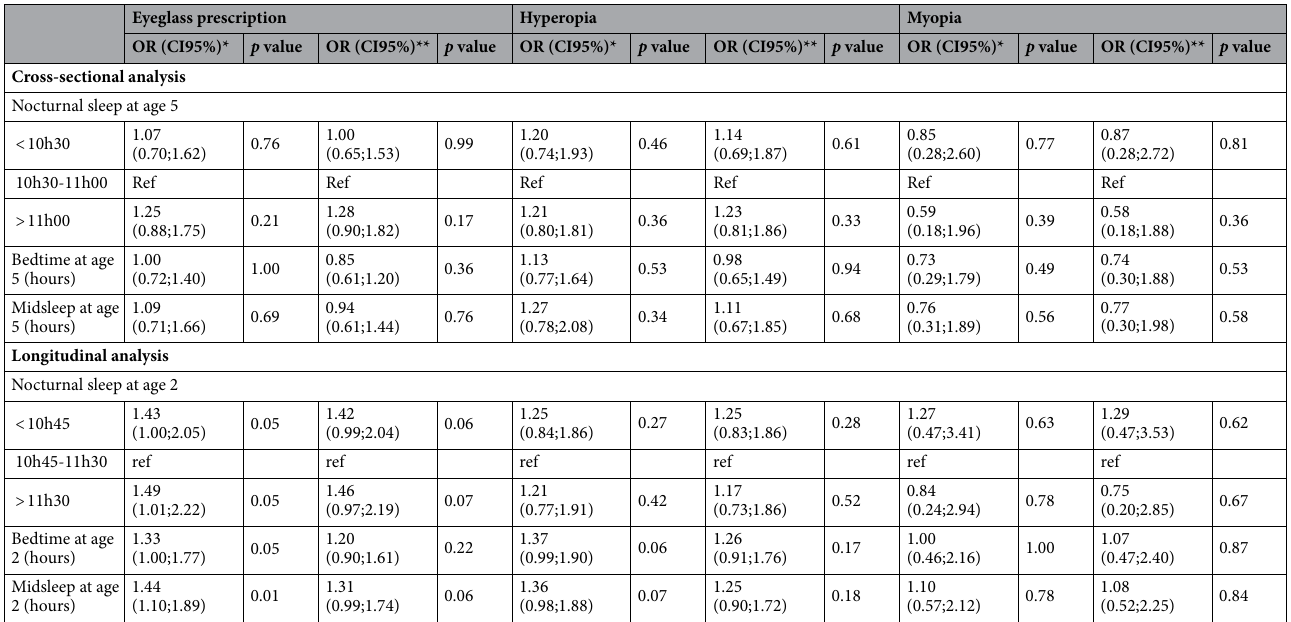
Table 2. Cross-sectional and longitudinal relations between each sleep characteristic separately (nocturnal sleep duration, bedtime and midsleep) and refractive errors at age 5 (n = 1130). *Adjusted for maternity hospital recruitment and exact age at 5 years data collection. **Additional adjustment for sex, gestational age, mother’s length of schooling, household income, child’s diurnal sleep at age 2, and season, daily time spent outdoors, and daily screen time at 5 years questionnaire